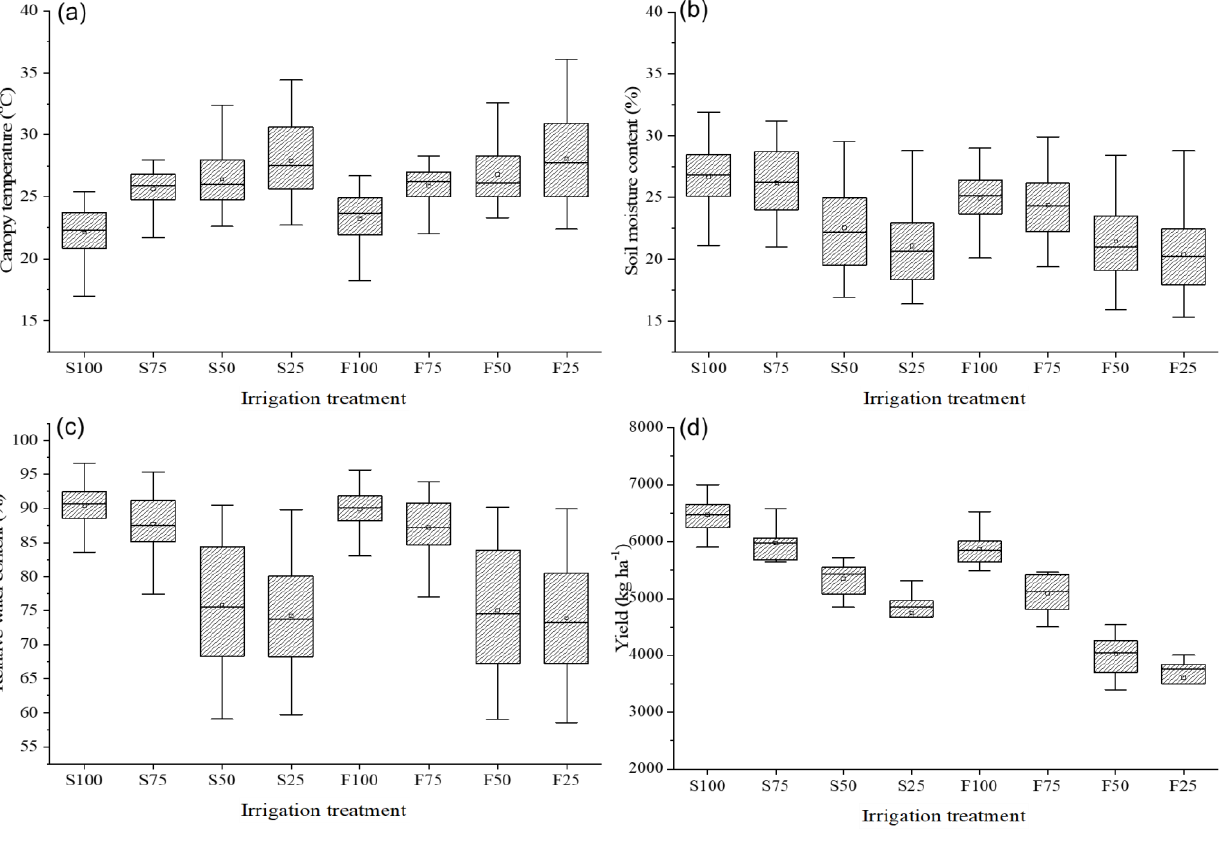
Net50 models for RGB and thermal imagery were tested for different combinations of epochs and batch sizes (Table 5). The model training accuracies increased with the in- crease in the number of epochs from 5 to 10 and over-fitting was observed for all the models when epochs increased to 20. Over different epochs, accuracy increased with the increase in batch size from 5 to 20. For the batch size of 20 and 250 iterations, overfitting was observed in Inception and ResNet50 with RGB imagery inputs and in AlexNet, GoogLeNet, and ResNet50 with thermal imagery inputs (Table 5). Extensive hyperpa- rameter tuning was performed with parameters listed in Table 2 to minimize overfitting and maximize the model accuracies. Post-tuning, the maximum training accuracies of 94.6%, 96.7%, and 95.6% were observed for AlexNet, GoogLeNet, and MobileNet V2, respectively with RGB imagery inputs at 10 epochs and batch size of 20 (Figure 5). While the Inception V3 and ResNet50 for RGB imagery inputs converged at 10 epochs, batch size of 15, and 300 iterations with respective accuracies of 92.7% and 97.1% (Figure 5c,e). For the thermal imagery inputs, the optimum hyperparameters were 10 epochs and a batch size of 15, which yielded maximum accuracies of 96.4%, 97.2%, and 98.5% for AlexNet, GoogLeNet, and ResNet50, respectively. Furthermore, 10 epochs and a batch size of 20 were found optimum for Inception V3 and MobileNet V2 models, and pertinent maximum accuracies were 98.0% and 95.3%, respectively (Figure 6). During hyperpa- rameter tuning, the model overfitting reduced significantly at 10 epochs without sacri-